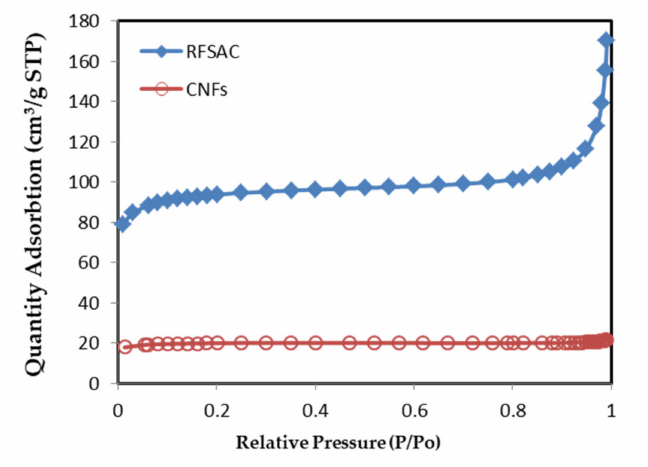
Figure 4. Nitrogen absorption isotherm RFSAC and carbon nanofibers.